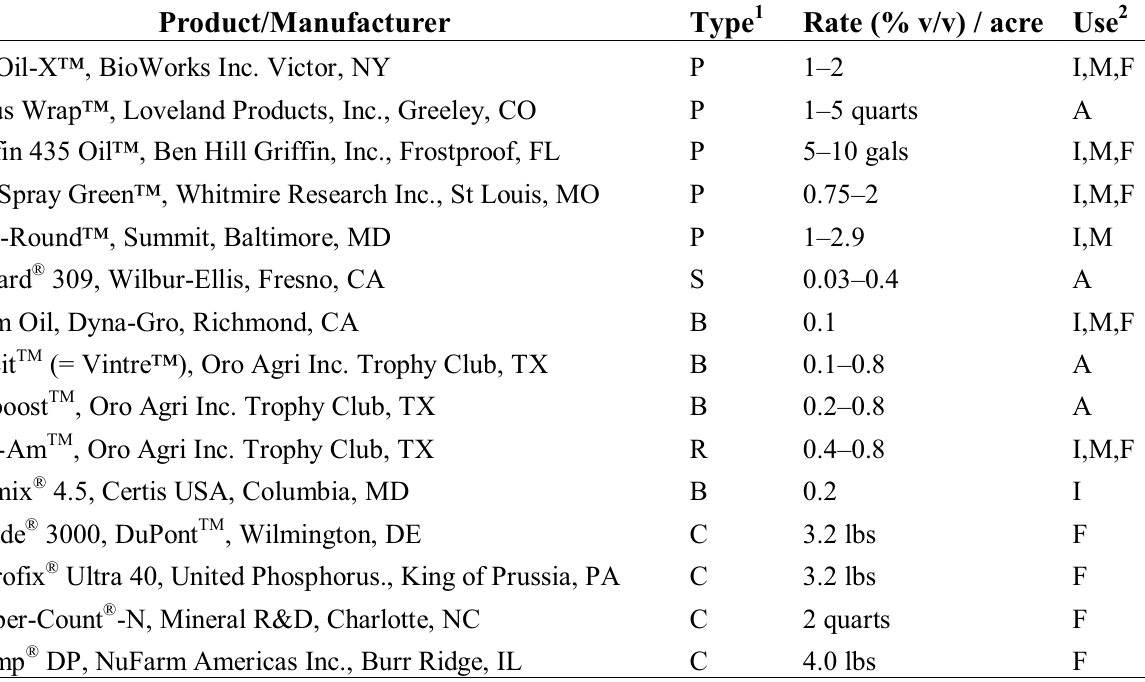
Table 1. List of products, types, pesticide rates and categories used in